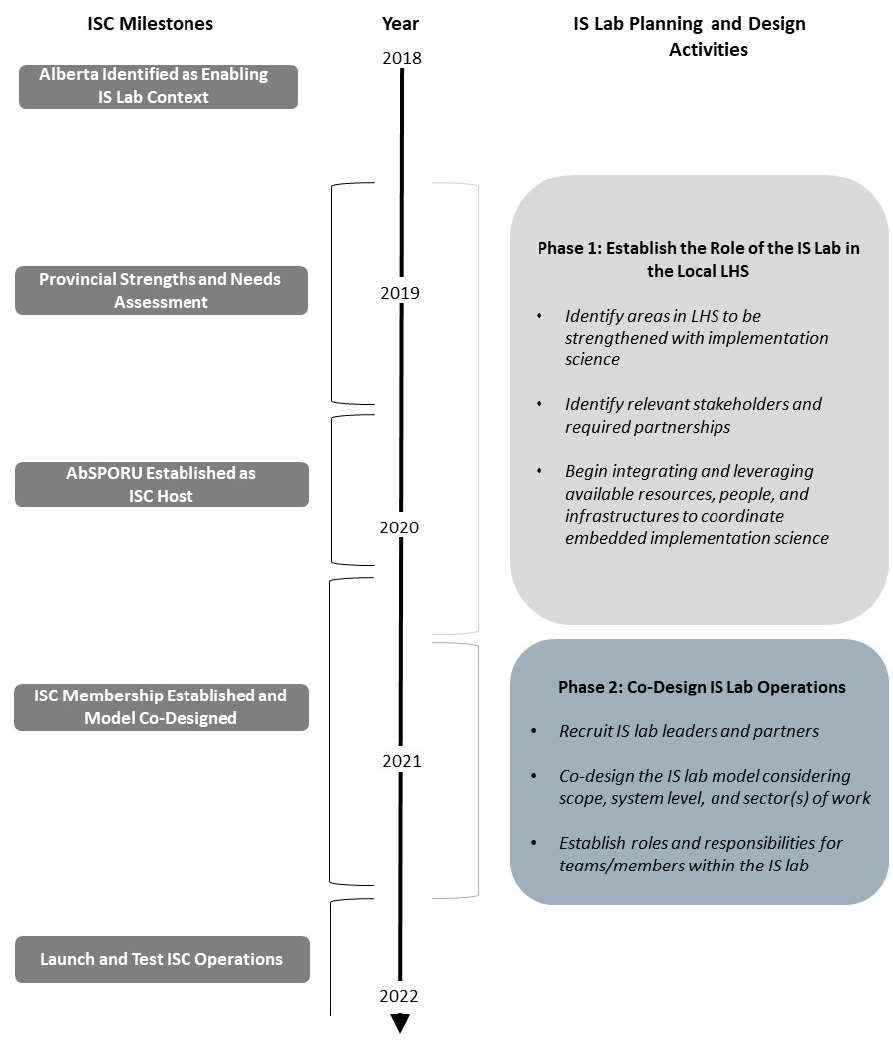
Figure 3. Timing and key activities for co-designing an IS lab.